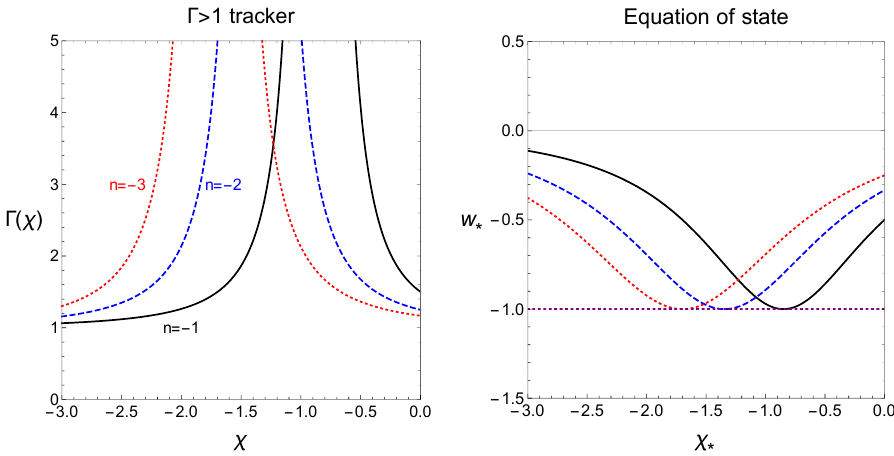
Figure 2 . (Left) The criterion for the tracker condition Γ as a function of χ . (Right) The equation of state for the tracker solution as a function of χ ∗ . n = − 1 , − 2 , − 3 are taken in black solid, blue dashed, and red dotted lines,